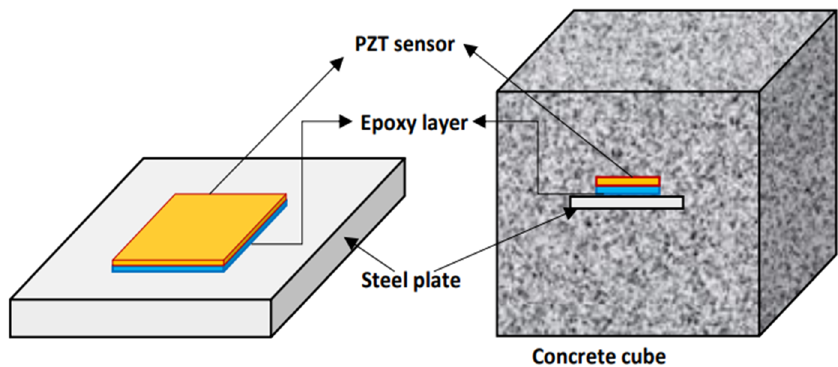
Figure 9. Schematic diagram concrete cube with embedded SSU. Table 4. Properties of the steel plate [38].